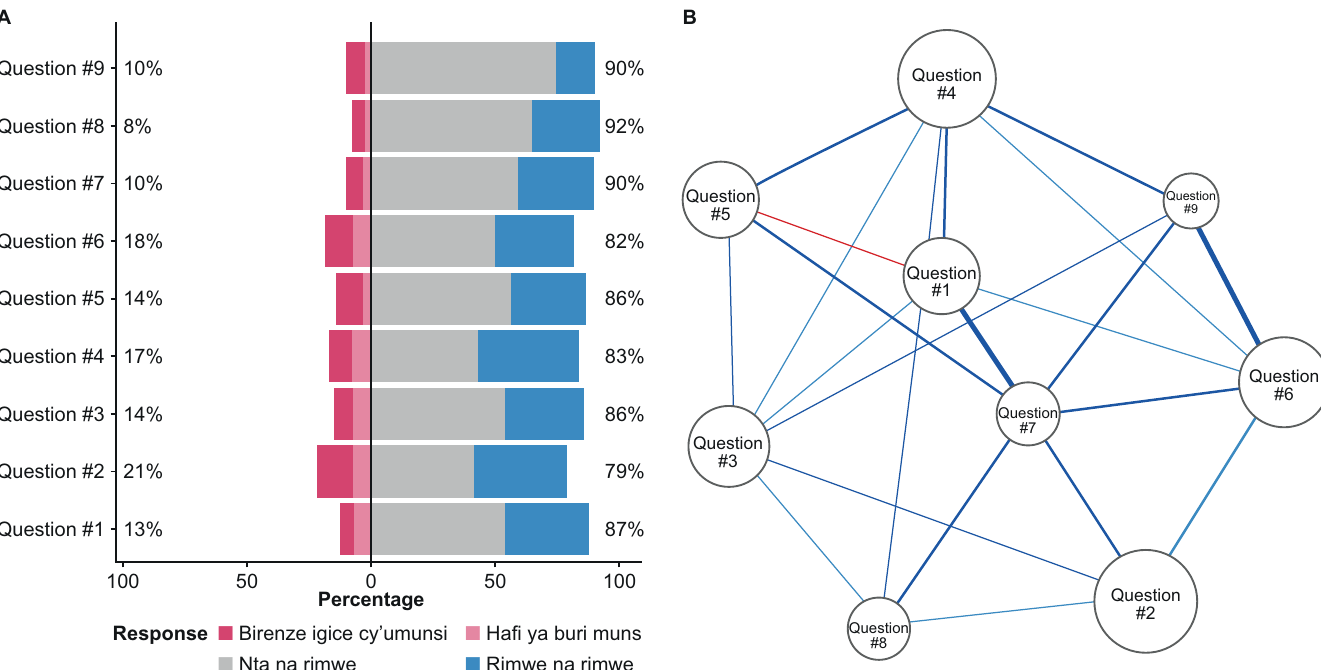
Fig 1. Likert responses distribution (A) and correlation pattern between items (B) of the Rwandan version of the PHQ-9. The size of the nodes (circles) represents the average response in the Likert scale for each item. The thickness of the lines (edges) represents the partial correlation between items. Nta na rimwe = not at all, never; Rimwe na rimwe = several days, sometimes; Birenze igice cy’umunsi = more than half the days; Hafi ya buri munsi = nearly every day.